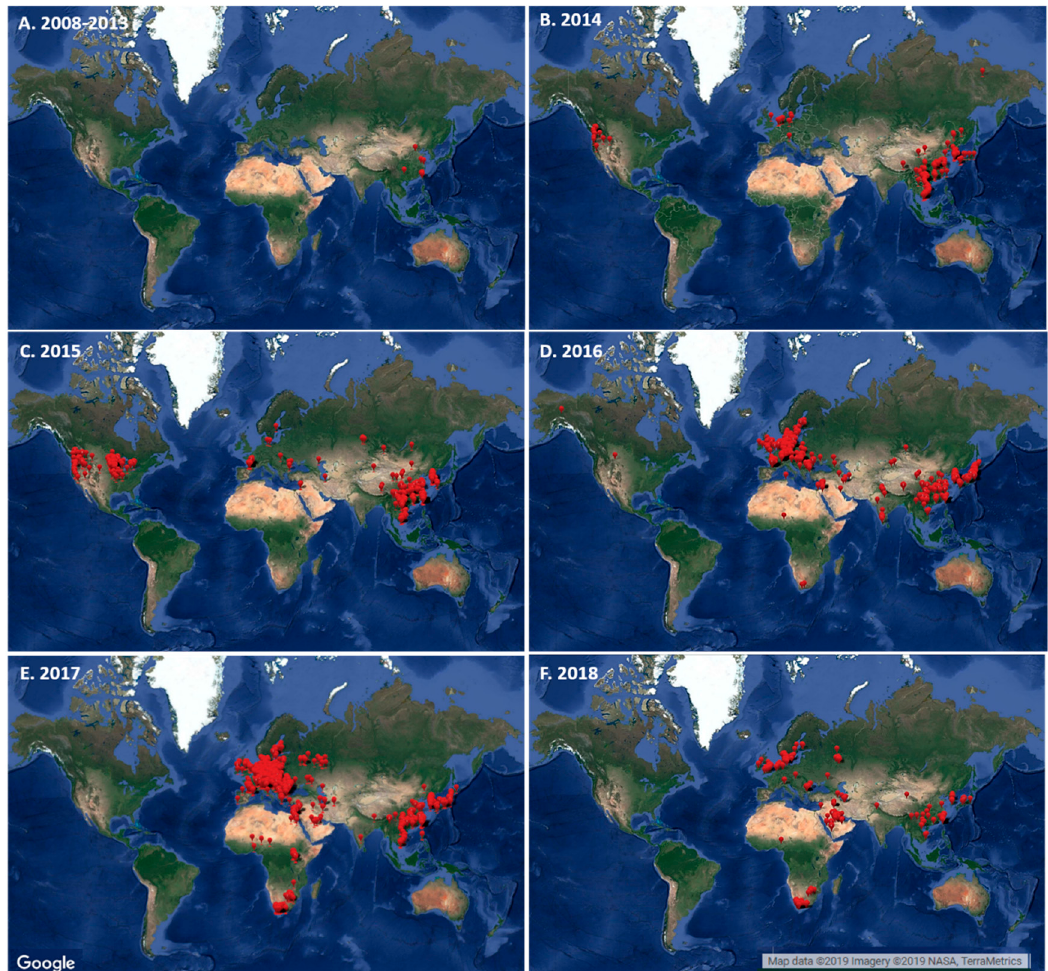
Figure 2. Distribution of reported H5Nx occurrences in various regions per specific period: ( A ) 2008–2013, ( B ) 2014, ( C ) 2015, ( D ) 2016, ( E ) 2017, and ( F ) 2018. Red pins in the map denotes a record of confirmed reported occurrence of H5Nx in the specified area. The map was generated using the collated reports recorded in the database of the Food and Agriculture Organization (FAO)’s Global Animal Disease Information System, Empress-I (http://empres-i.fao.org/eipws3g/) and was mapped